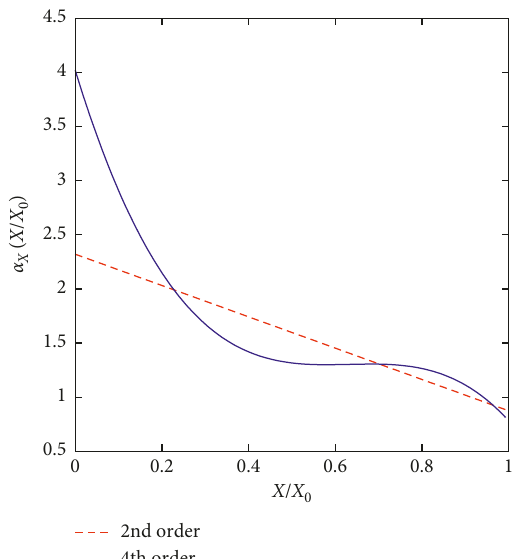
Figure 2: Experimental shrinkage functions α